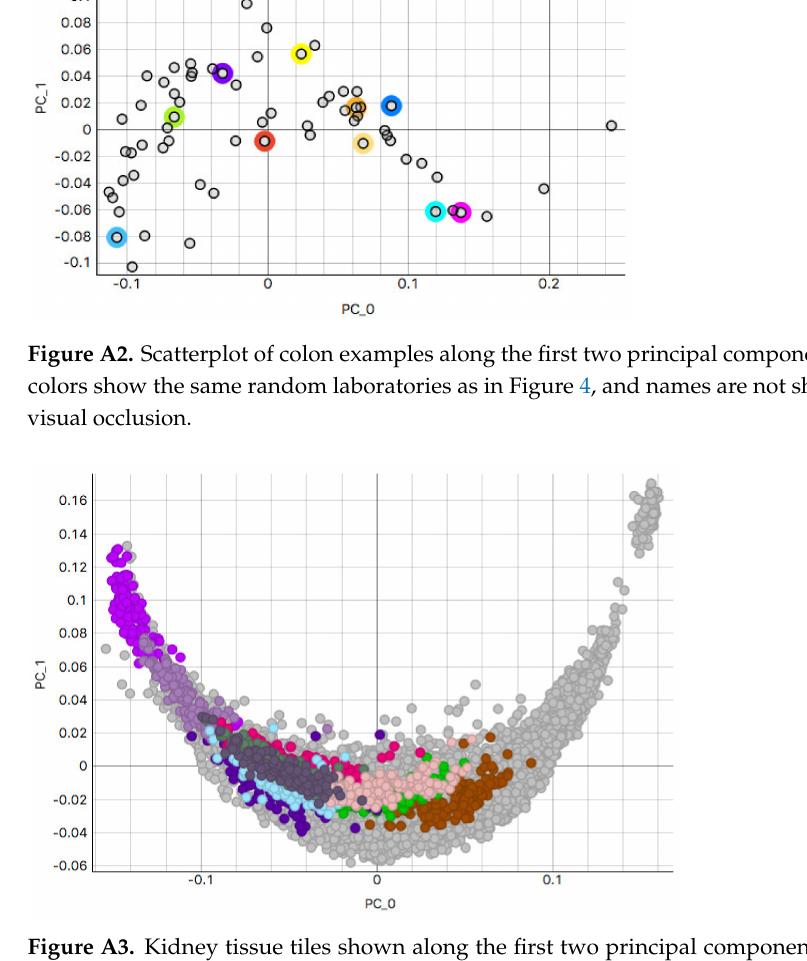
Figure A3. Kidney tissue tiles shown along the first two principal components. Colors represent random laboratory tiles. Due to the high number, only a small number of tiles can be shown without occlusion.